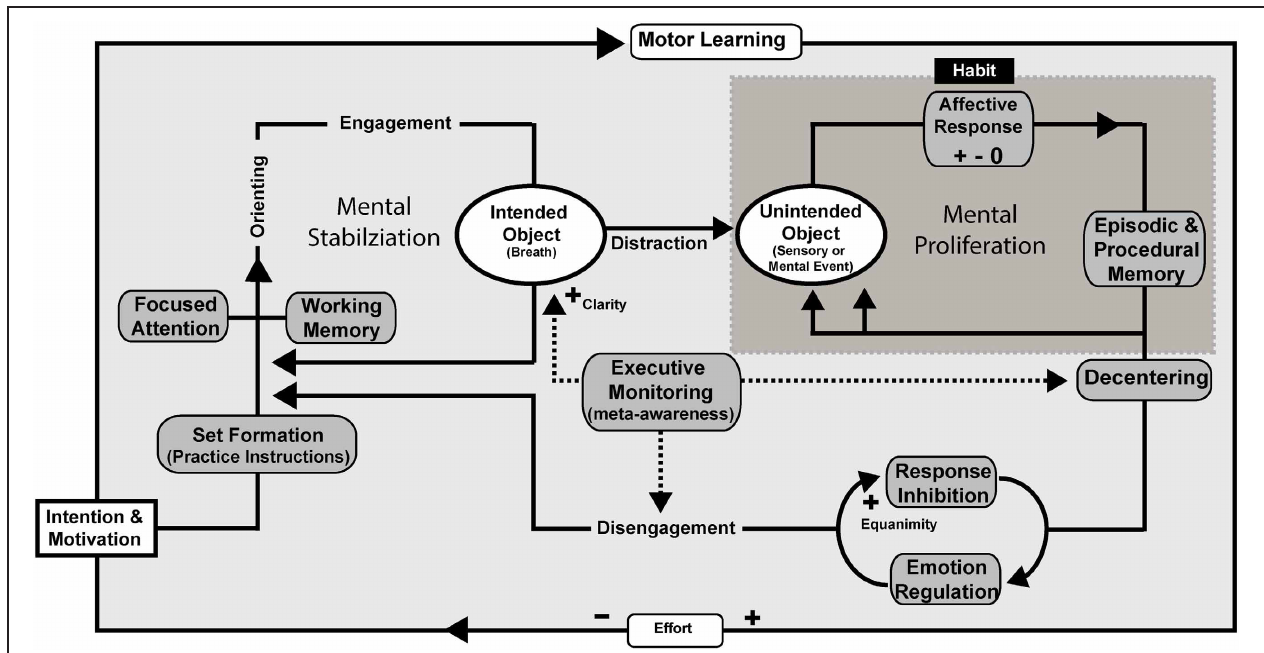
FIGURE 3 | Mindfulness process model—concentrative practice. FA meditation using the breath as the object of focus is illustrated as an example, but the processes are proposed to be the same across concentration styles of practice. Intention is formed along with motivation to practice before an executive “set” is created. Executive set is supported by the working memory system in order to implement and maintain practice instructions. Focused attentional networks are recruited and sustained along with support by component mechanisms including executive monitoring, emotion regulation, and response inhibition. Unintended objects of distraction can include any stimulus available to extero- or interoceptive sensory and mental processes. Affective responses to unintended objects can